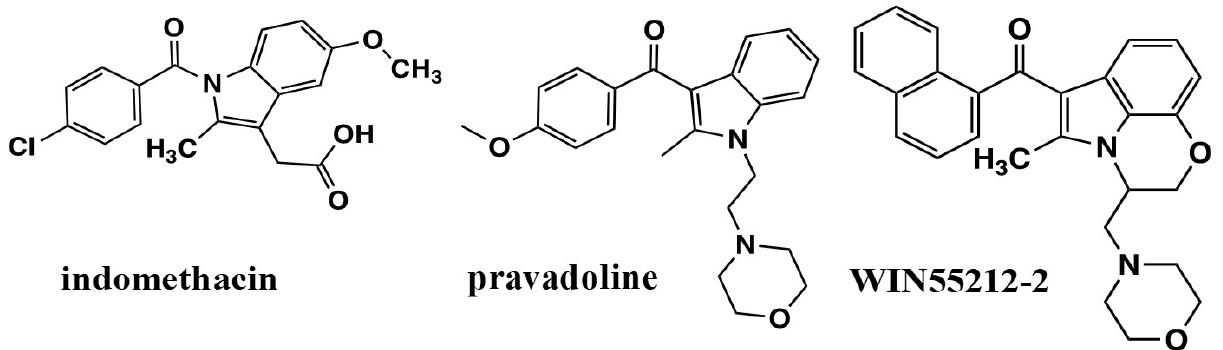
Figure 2. NSAID indomethacin, and aminoalkylindoles pravadoline and WIN55212-2.